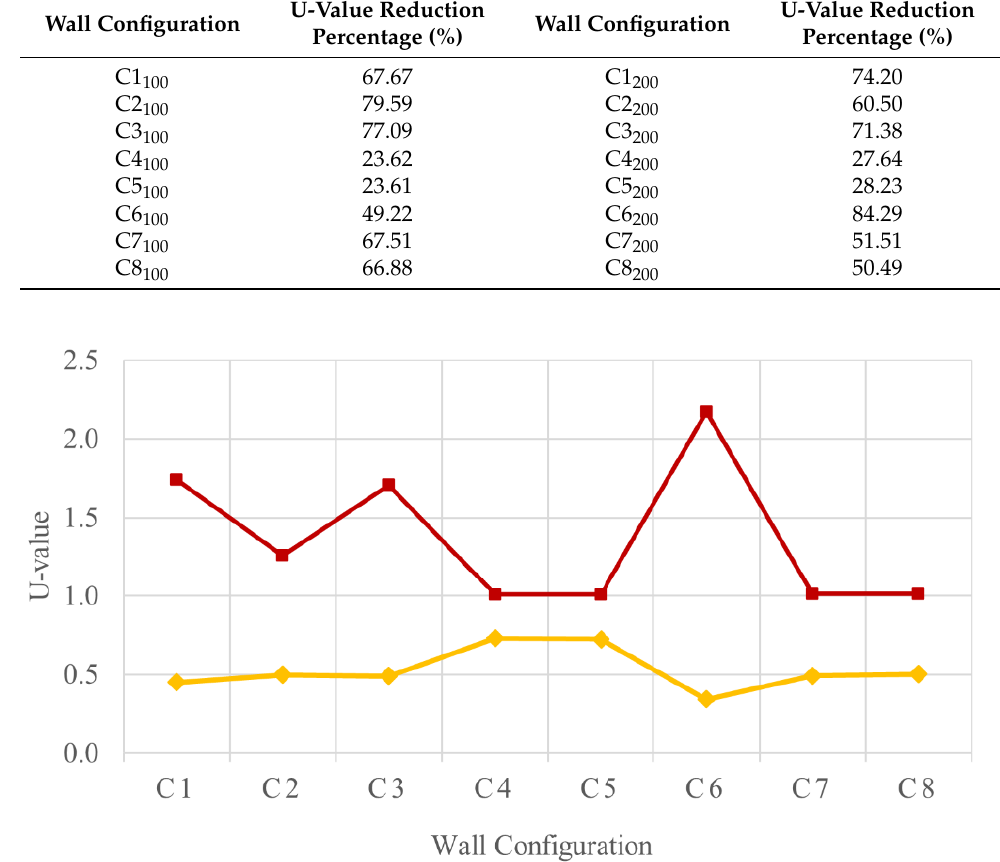
Figure 9. The U -value results obtained for 100 mm and 200 mm wall configurations with and without cavity insulation. Wall configurations with double-row triangular arrangements did not attain a no- ticeable reduction in U -values with the integration of E-PLA insulation. Observed reduc- tions in U -values were nearly 23% and 28% for 100 mm and 200 mm wall panels, respec- tively. However, all the other wall configurations attained a significant improvement in energy performance with E-PLA insulation. The measured reduction in U -values for the single-row triangular, lattice, and sinusoid wall arrangements with insulation ranged